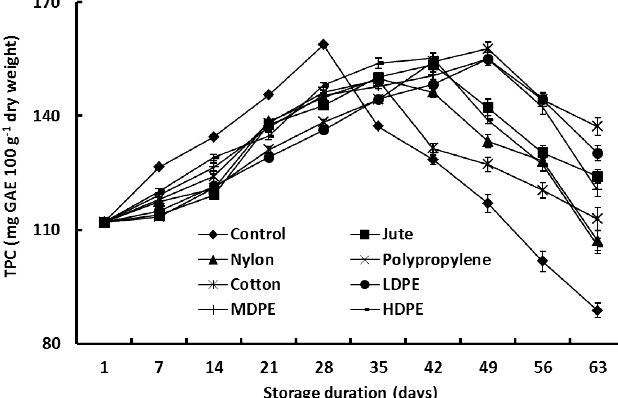
Fig. 5: Total phenolic contents in potato tubers stored using different pa- ckaging materials were highest at the end of the storage period when stored in polypropylene packages. Vertical bars show ±SE of means (n-3). Interaction between storage intervals and packaging materials was significantly different at p ≤